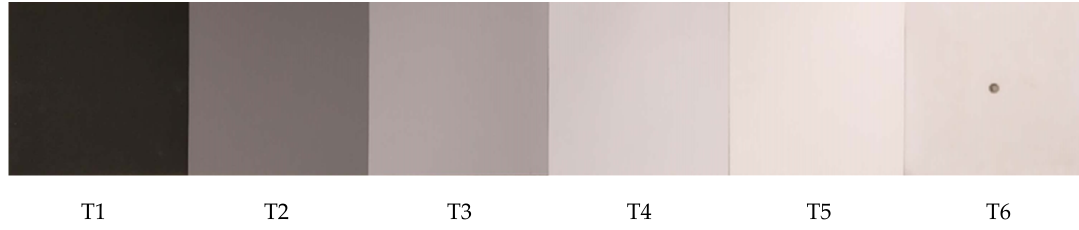
Figure 2. Images of the greyscale reflectance targets used in this study.